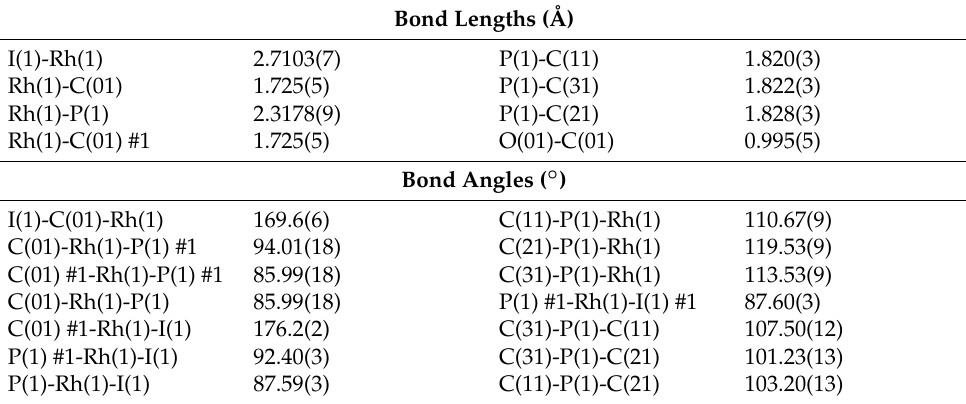
Table 3. Bond lengths [Å] and angles [°] for trans- [Rh(CO)(I)(PPh 3 ) 2 ] · (CH 3 COCH 3 ) ( B5a ). Bond Lengths (Å) Table 3. Bond lengths [Å] and angles [ ◦ ] for trans- [Rh(CO)(I)(PPh 3 ) 2 ] · (CH 3 COCH 3 ) ( B5a ).